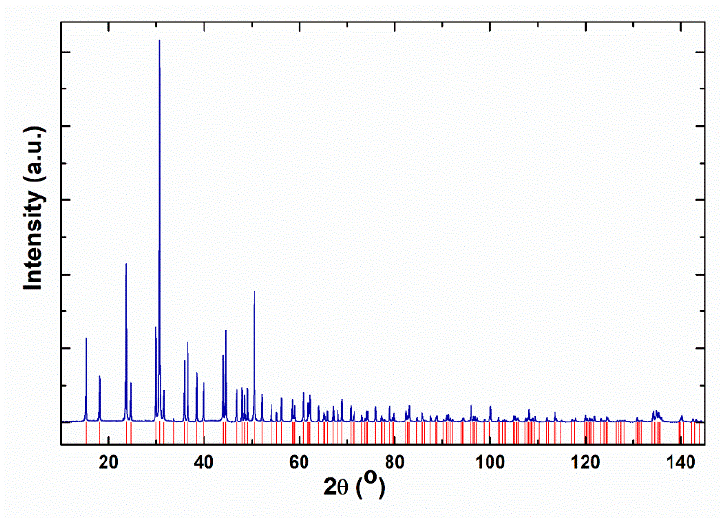
Figure 7. XRPD spectrum of LYSB crystal. The vertical sticks (in red color) correspond to PDF card 04-018-1225 of trigonal phase (space group R32 ). (Reprinted with permission from ref. [13], copyright 2019 American Chemical Society).